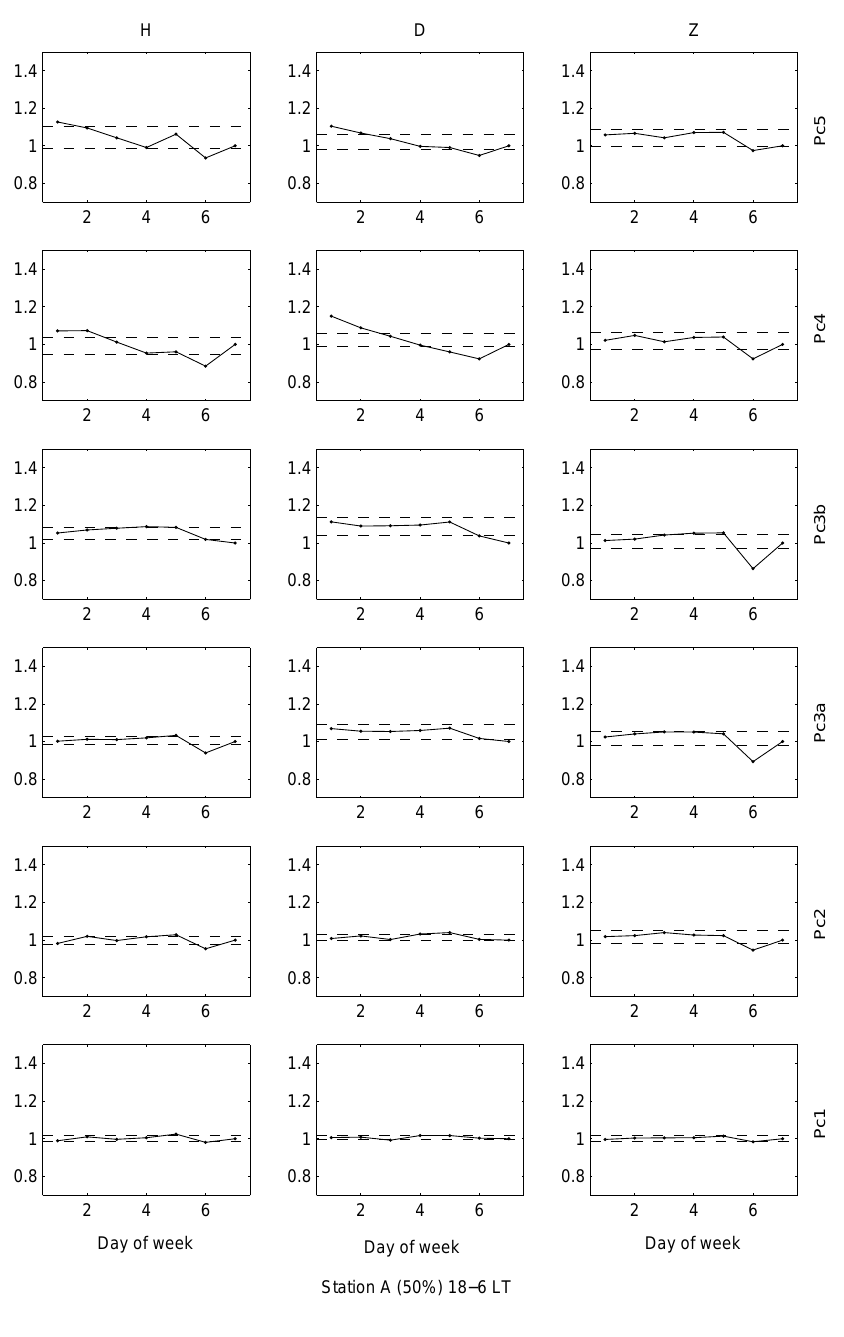
Fig. 3. Weekly variation of the nighttime average power of magnetic field components in different frequency bands at Station A (50% of original